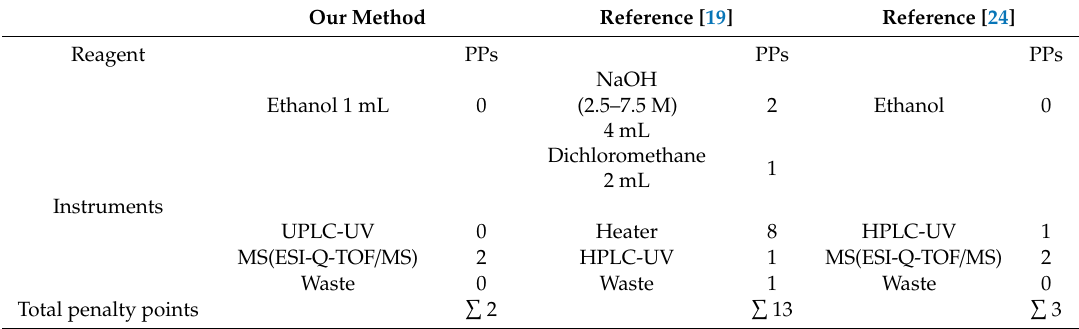
Table 3. Penalty points (PPs) for determination of phenolic compounds in this study and others. Our